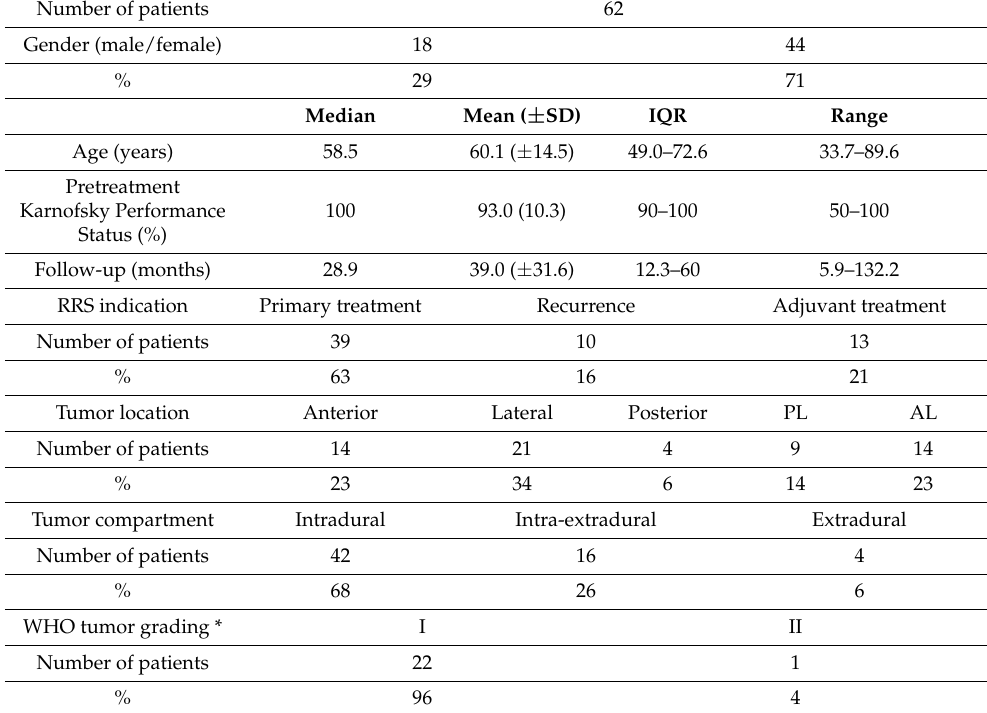
Table 1. Patient characteristics.